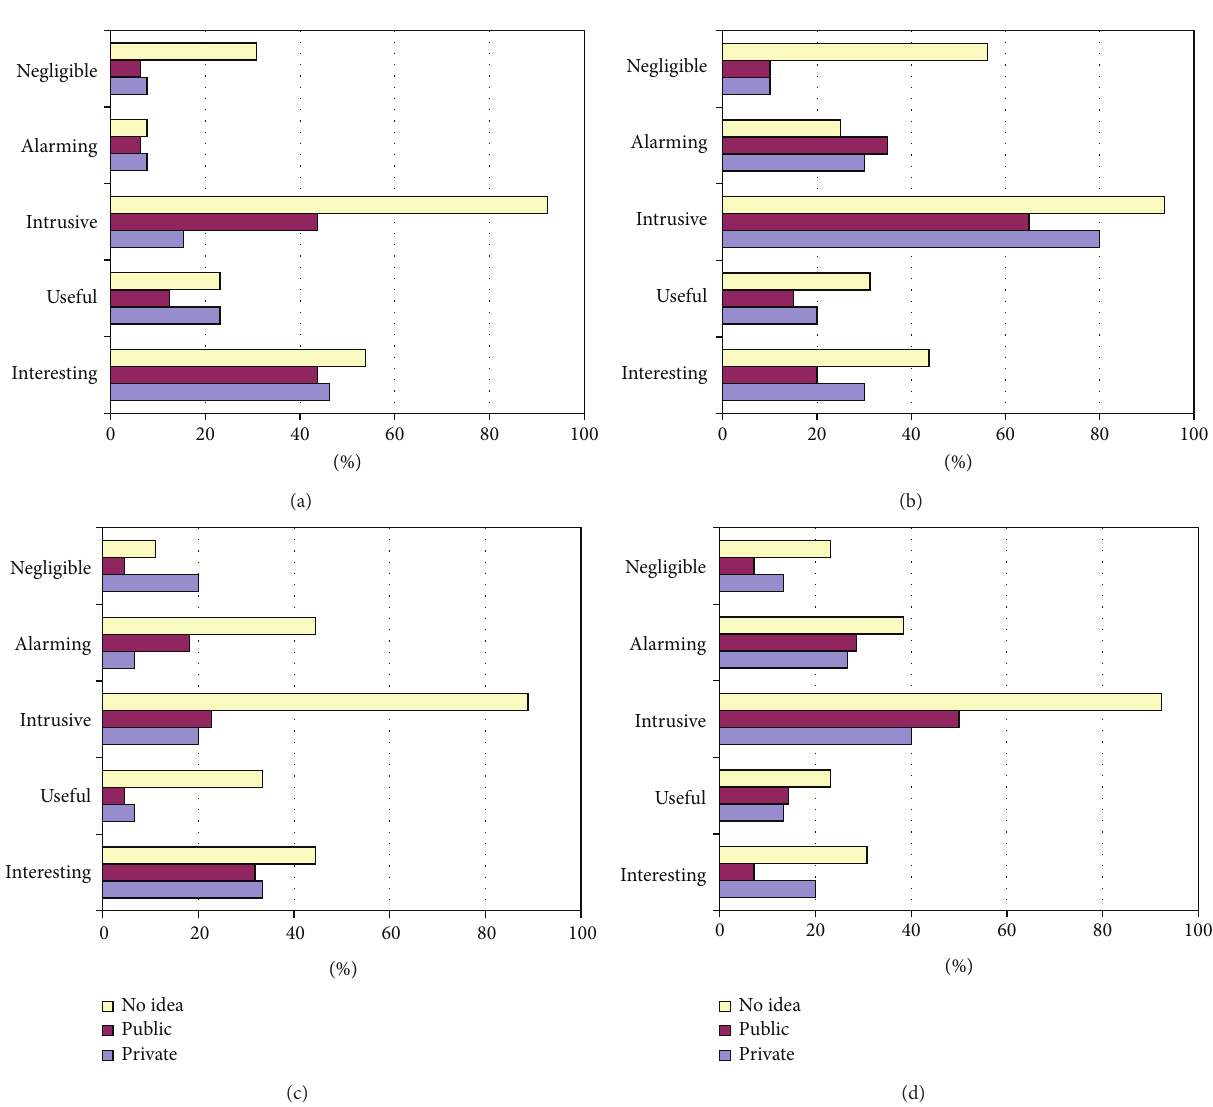
Figure 22: Definition given according to the profile type: (a) DN men; (b) DN women; (c) DI men; (d) DI